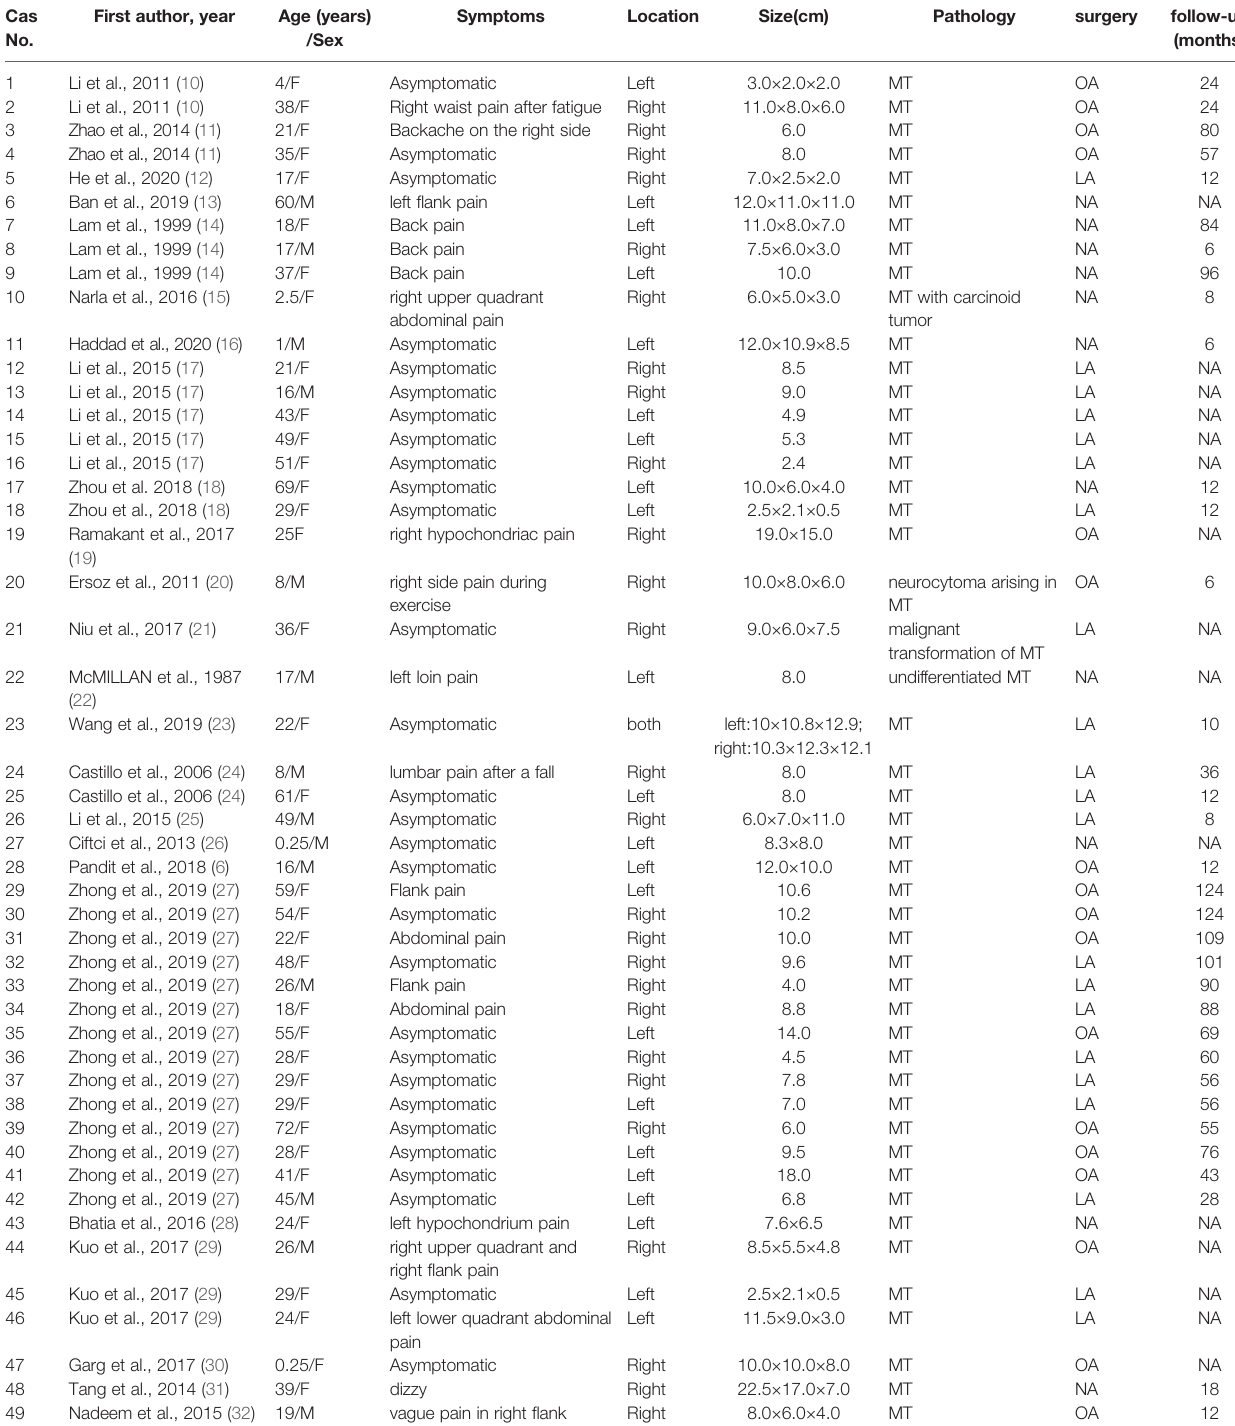
TABLE 2 | Review of characteristics of adrenal